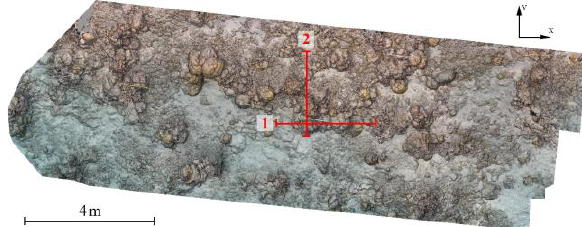
Fig.7: Location of profile 1, parallel to the x-axis, and profile 2, parallel to the y- axis.